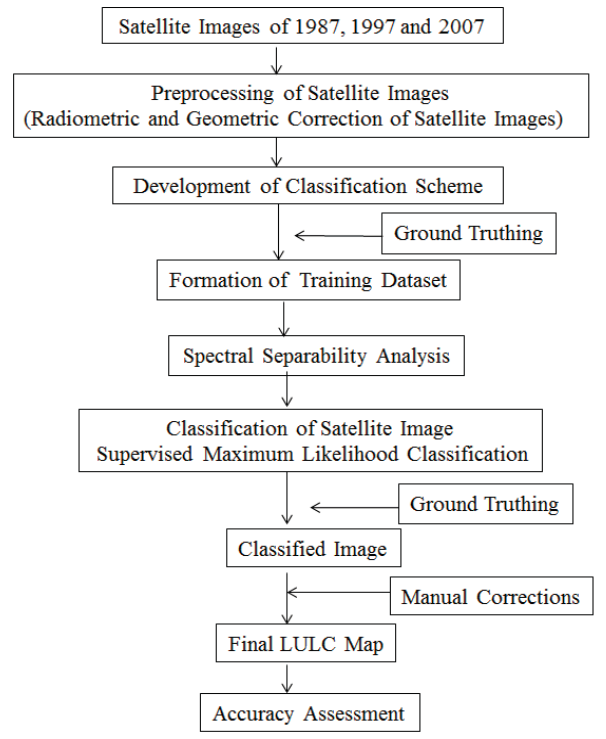
Figure 3. Flowchart shows methodology adopted for LULC mapping